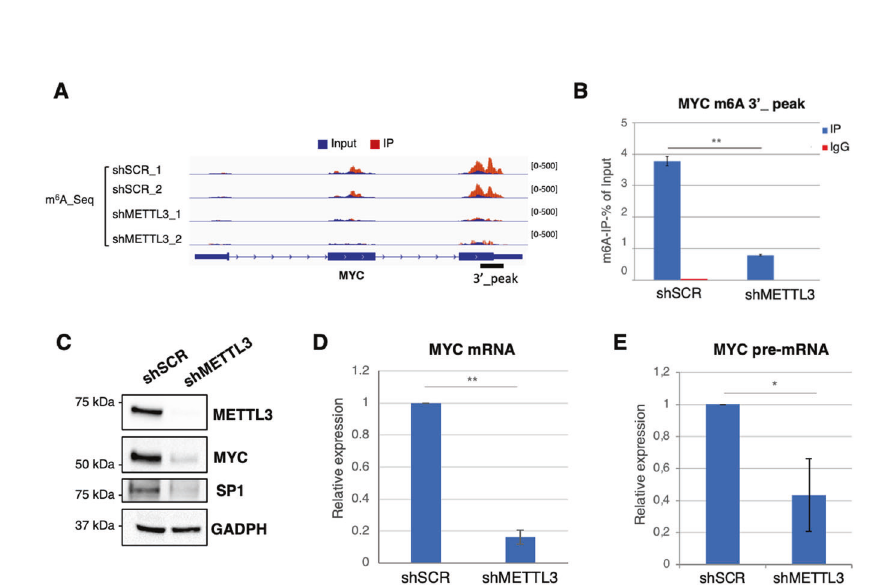
Fig. 6 METTL3 regulates MYC levels in CML. A The m 6 A abundances on MYC mRNA in shMETTL3 and control shSCR cells as detected by m 6 A-seq. B m 6 A-IP-qPCR validation of MYC m 6 A peaks in shSCR and shMETTL3 cells. Values are expressed as percentage of input. IgG was used as control; n = 3. C Western blot analysis in shMETTL3 and shSCR K562 transduced cells. Protein levels were analyzed 48 h after puromycin selection. D , E Expression levels of MYC mRNA ( D ) and MYC pre-mRNA ( E ) in shSCR and shMETTL3 cells. Values are normalized against ACTB and expressed as relative quantities with respect to shSCR cells set to a value of 1; n = 3. In all panels, relative RNA quantity in the bars is represented as the mean of the fold change with standard deviation. The ratio of each sample versus its experimental control These data indicate that METTL3 regulates ribosome levels and translation indirectly, by affecting MYC levels, and directly, by methylating speci fi c mRNAs, such as PES1, and stimulating its translation. In the latter case, both catalytic -dependent and -independent roles are required.